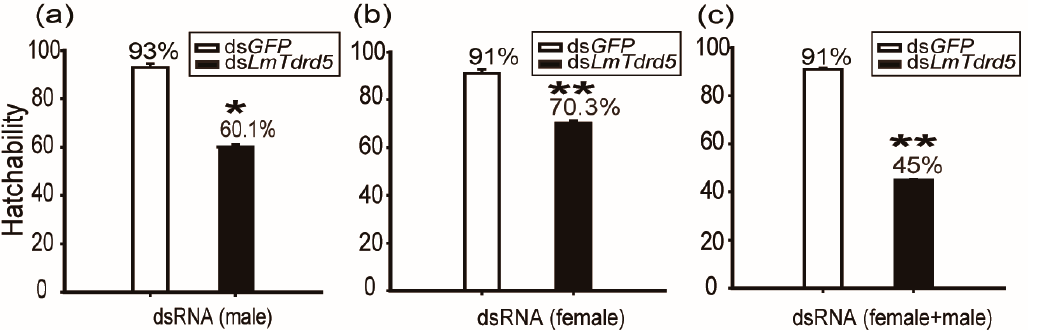
Figure 2. Analysis of hatchability. Hatchability was calculated as a percentage. ( a ) Ds LmTdrd5 or ds GFP injected only in males. ( b ) Ds LmTdrd5 or ds GFP injected only in females. ( c ) Both males and females injected with either ds LmTdrd5 or ds GFP . Statistically significant differences are indicated as follows: * p < 0.05; ** p < 0.01.